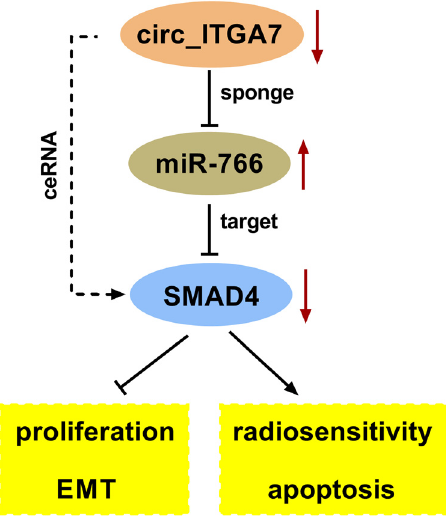
Figure 9: A schematic diagram illustrating how the circ_ITGA7/ miR766/SMAD4 axis regulates CRC cell growth and